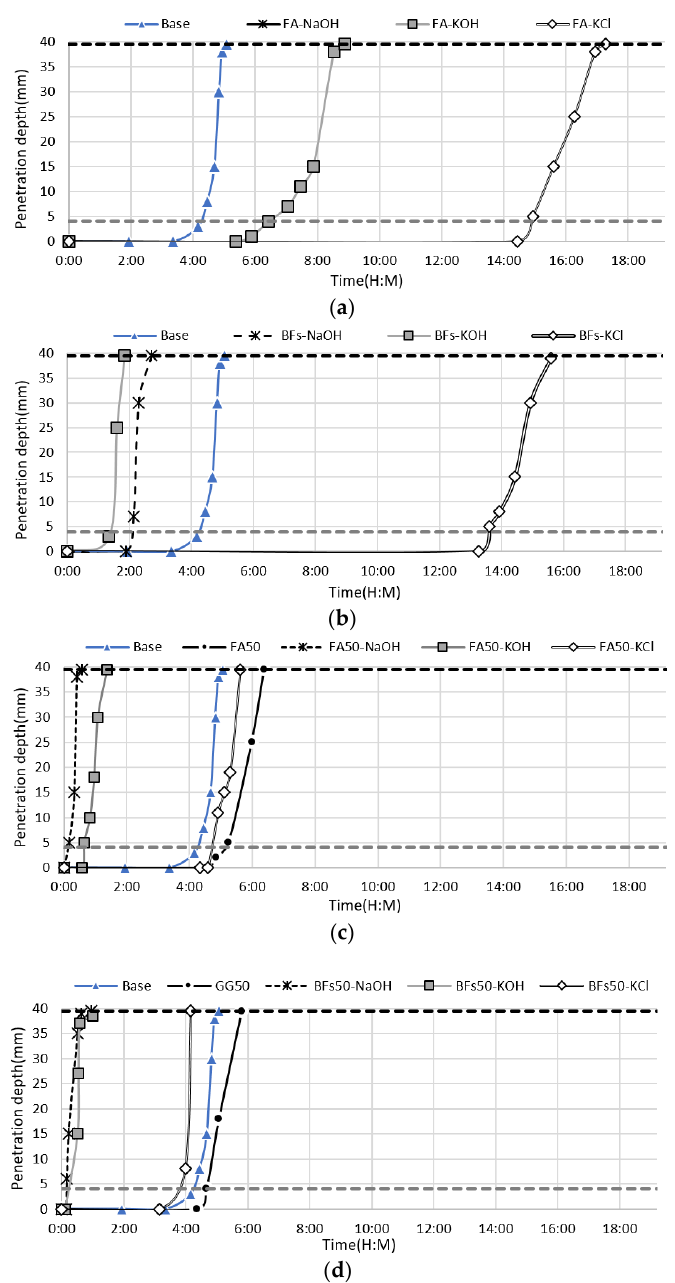
Figure 3. Setting of the cement-containing and non-cement mortar with KCl separated from CBD, NaOH, and KOH as activators, namely, ( a ) 100% FA, ( b ) 100% BFS, ( c ) 50% FA and 50% OPC, and ( d ) 50% BFS and 50% OPC.